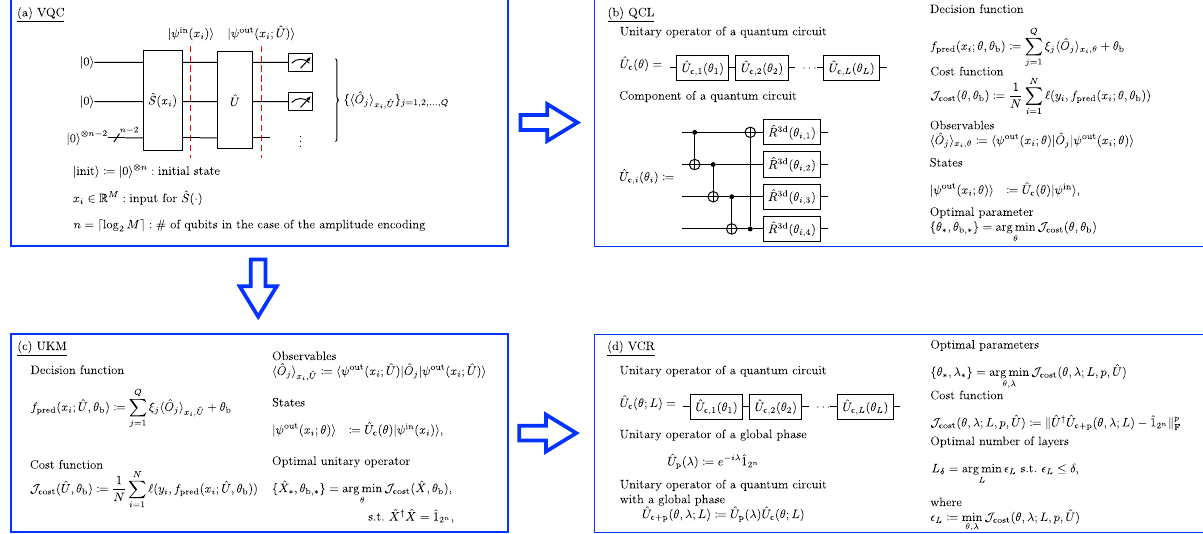
Figure 1. Schematic of the algorithms discussed in this paper: ( a ) A general form of a hybrid quantum-classical classifier, which we refer to as a VQC, ( b ) QCL, ( c ) UKM, and ( d ) VCR. ( a ) In the architecture of a VQC, the initial state is | init � := | 0 � ⊗ n . We first encode a given classical vector x i : | ψ in ( x i ) � := ˆ S ( x i ) | init � . One can embed x i into a higher dimensional vector φ( x i ) ∈ R L with L = O ( M c ) and then use the rest of the framework;